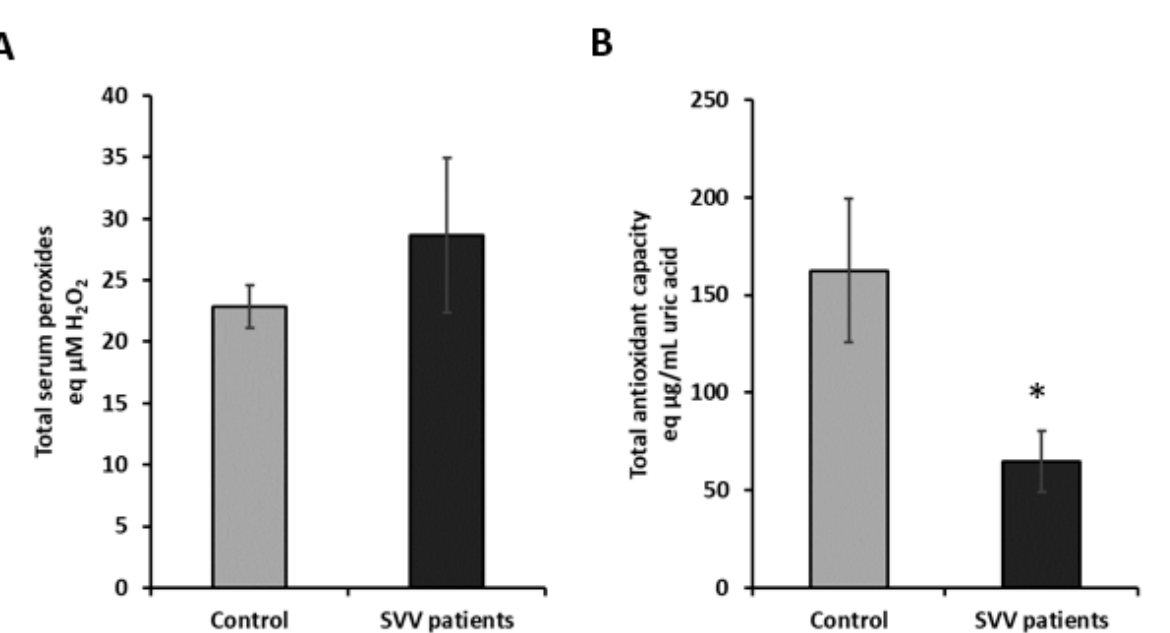
Figure 3. Body redox homeostasis is altered in SVV patients. ( A ) Total serum peroxides; ( B ) total antioxidative capacity. Significance * p < 0.05 compared to control.